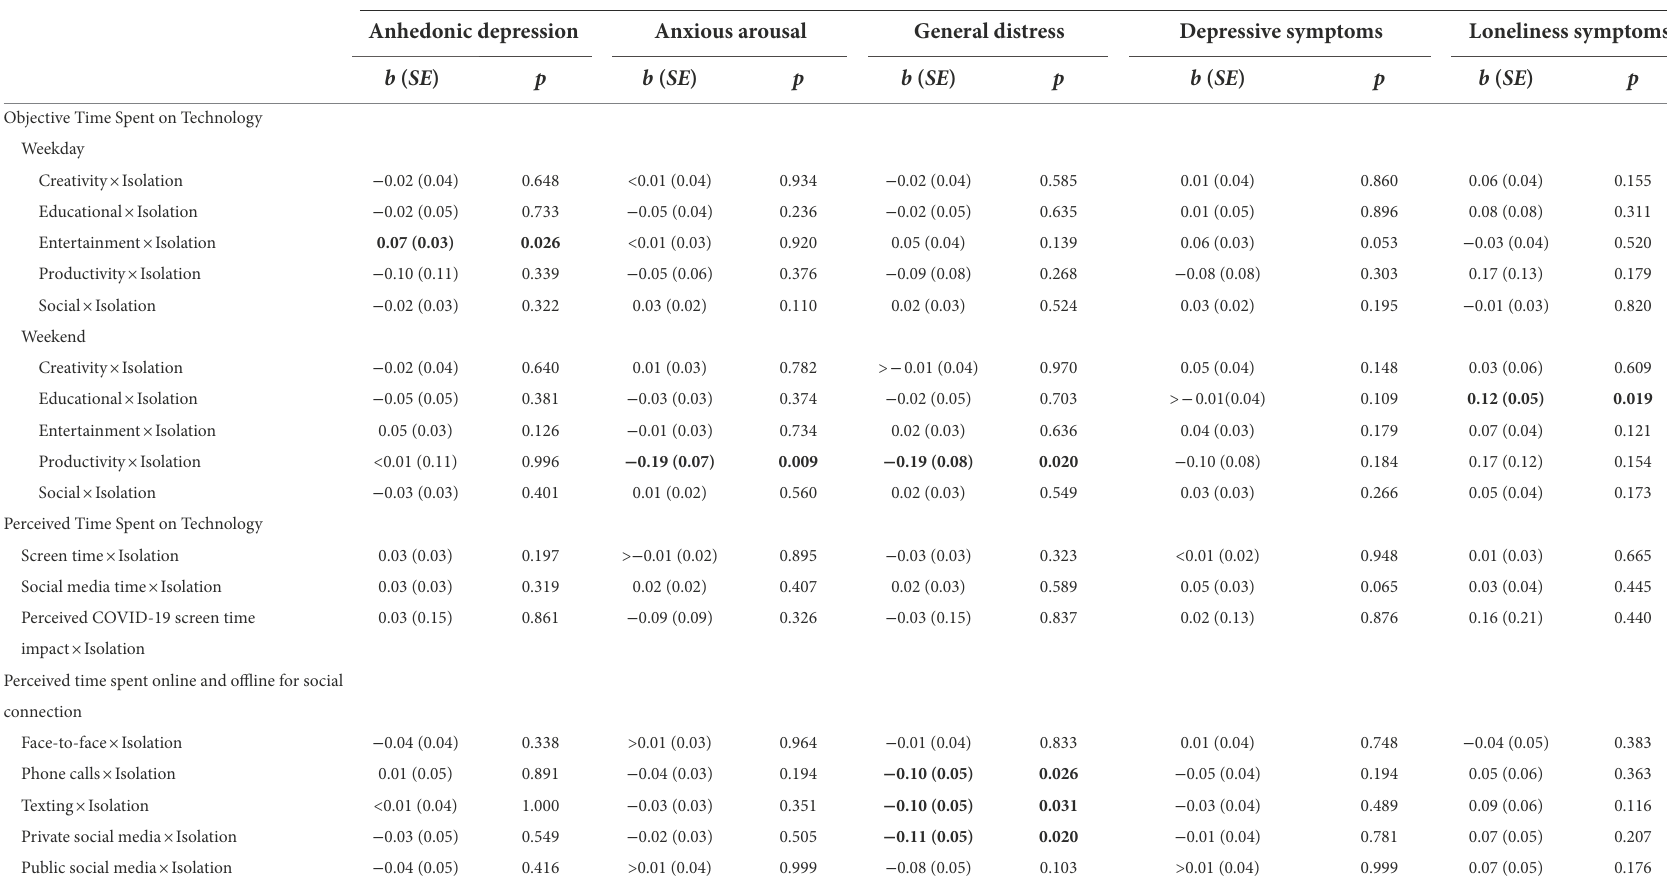
TABLE 3 Differential associations for more isolated students: associations between digital technology engagement and mental health as moderated by COVID-19-related social